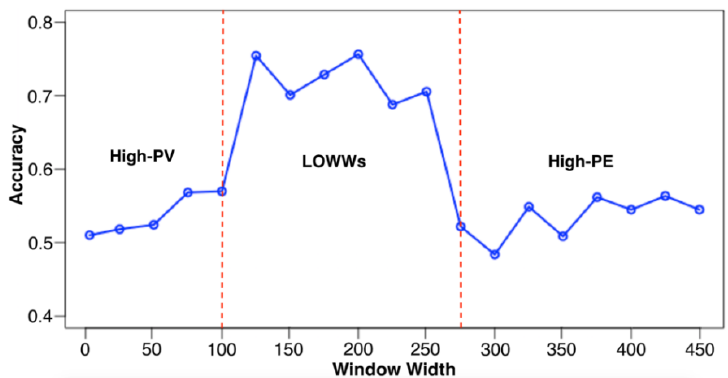
Figure 1. Correlation between Window Width (WW) and accuracy.